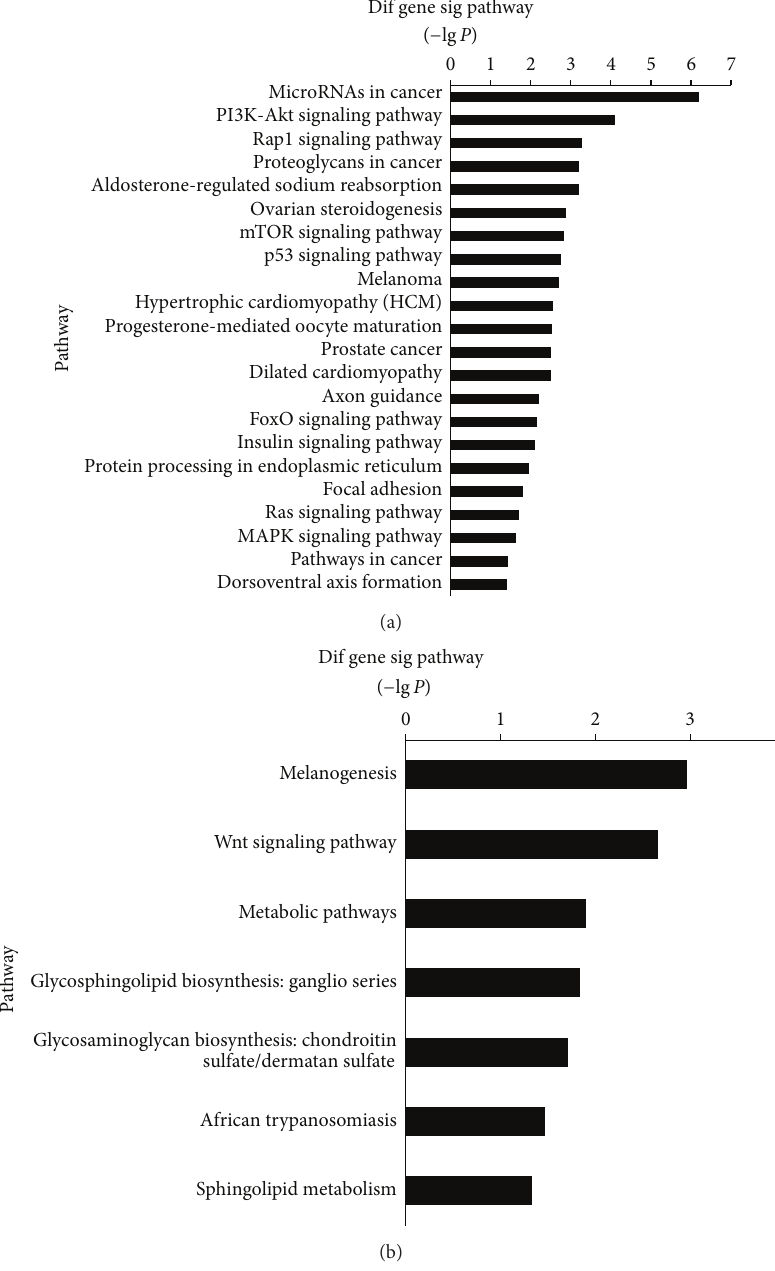
Figure 7: Pathway enrichment from integrated analysis of differentially expressed miRNAs and mRNAs in conjunction with target predictions. (a) Pathway enrichment for miRNAs downregulated with targets in upregulated genes in Sca-1 + CD31 − cells compared to Sca- 1 + CD31 + cells. (b) Pathway enrichment for miRNAs upregulated with targets in downregulated genes in Sca-1 + CD31 − cells compared to Sca-1 + CD31 +